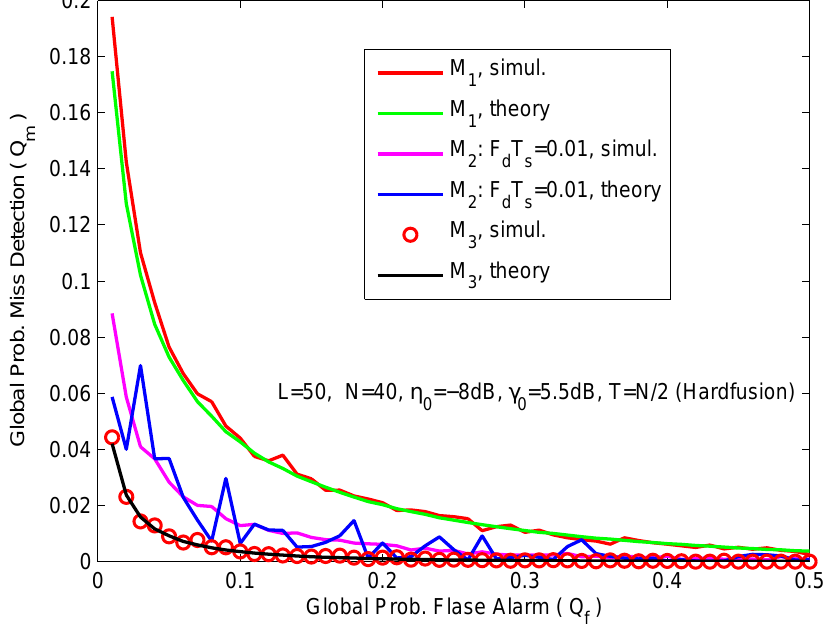
Figure 7. ROC curves for different channel